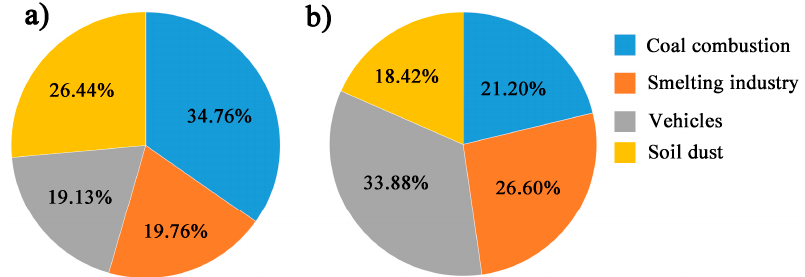
Figure 4. The contributions of the four sources to PM 2.5 -bound elements during the heating period ( a ) and non-heating period ( b ).